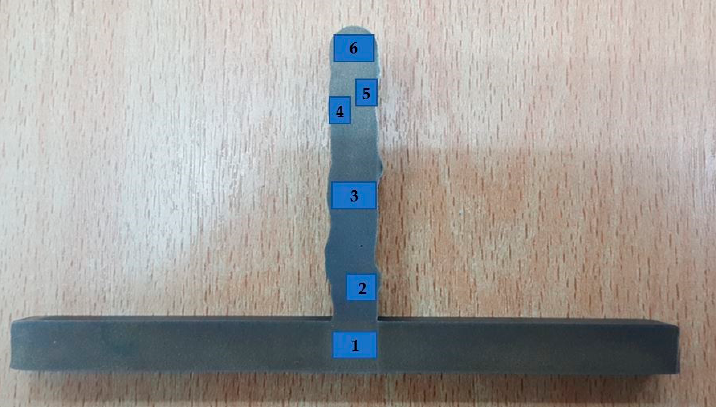
Figure 15. Position of the microstructure measurement of the transverse section of the specimen.